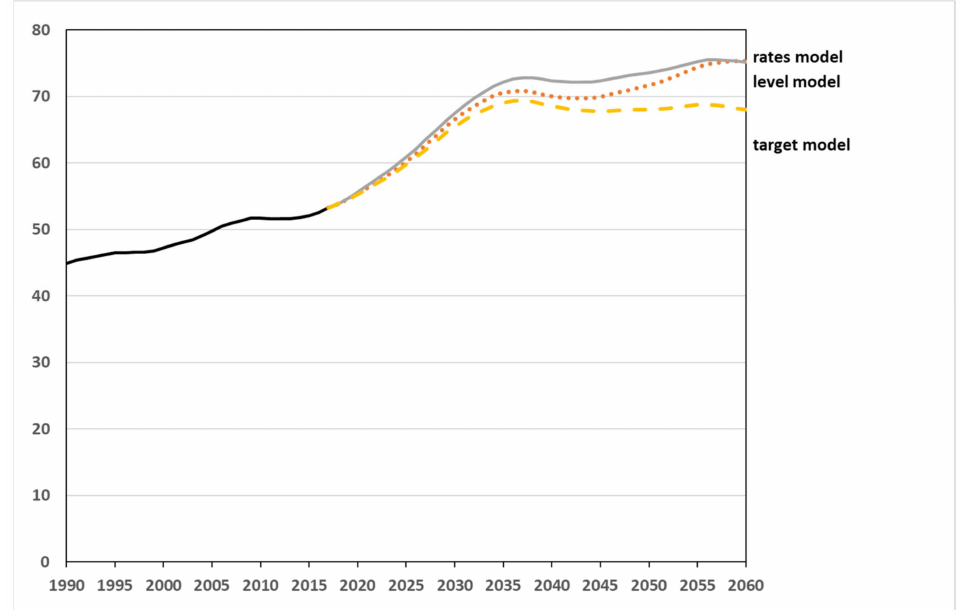
Figure 10. Development of the total dependency ratio (as %) until 2060—simulation results from 2019 onwards. (Sources: [54]; own computation and